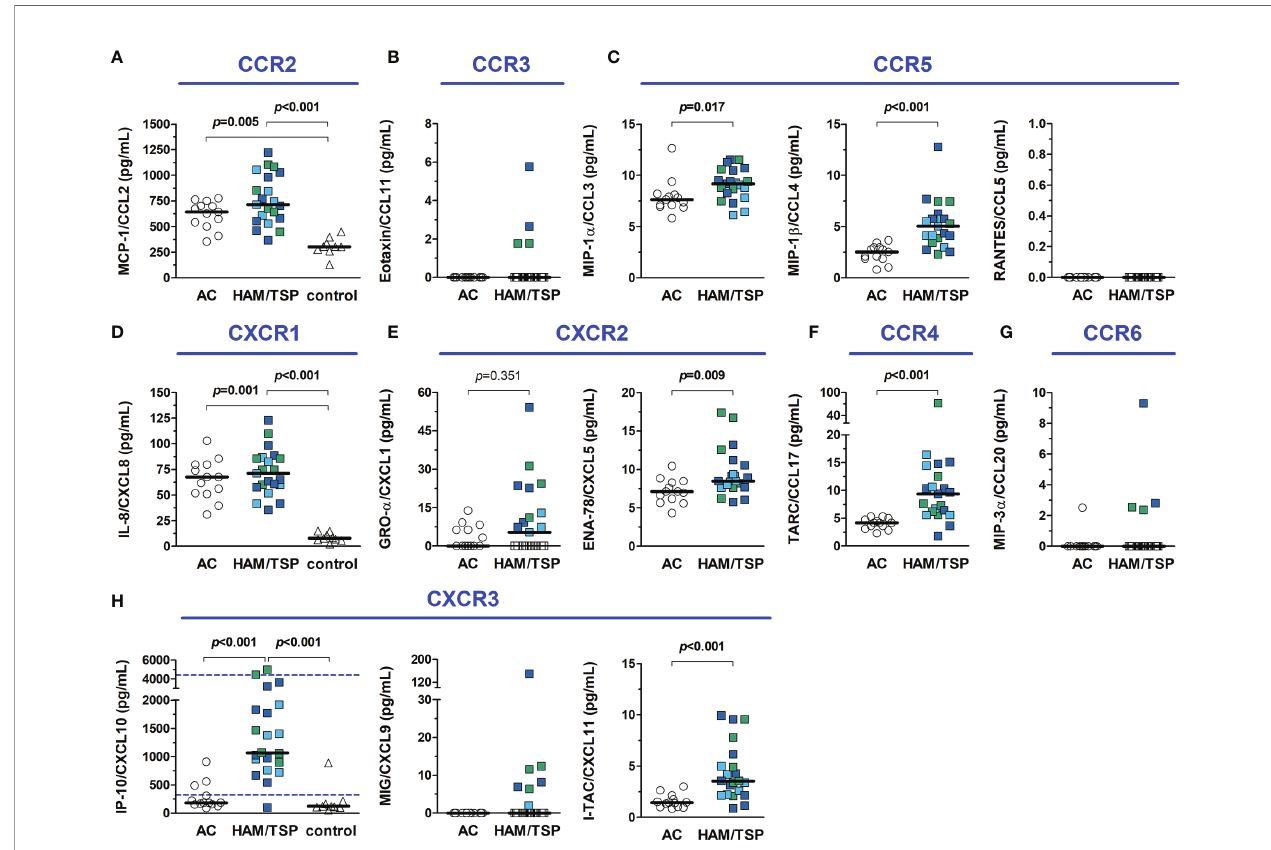
FIGURE 6 | In fl ammatory chemokines in the cerebrospinal fl uid (CSF) of HTLV-1 asymptomatic carriers (AC) and HAM/TSP patients. Chemokines were quanti fi ed with a multiplex cytometry bead-based immunoassay, and graphs were organized according to their respective receptors, shown in blue. (A) CCL2 (B) , CCL11, (C) CCL3, CCL4 and CCL5, (D) CXCL8, (E) CXCL1 and CXCL5, (F) CCL17, (G) CCL20, and (H) CXCL9, CXCL10 and CXCL11. HAM/TSP patients were identi fi ed according to the speed of disease progression as very slow (light blue), typical/slow (dark blue) and rapid (green). Comparisons between two groups were performed with Mann-Whitney test, and the analysis between three groups was carried out with Kruskal-Wallis test with Dunn ’ s post-test for multiple comparisons, and differences with p-value < 0.05 were considered signi fi cant. Dashed lines in the graph for IP-10/CXCL10 data represent the upper and lower cut-offs for CXCL10 concentration in the CSF to predict the speed of HAM/TSP progression as very slow (< 320 pg/mL), typical/slow (320 – 4,399 pg/mL), and rapid ( ≥ 4,400 pg/mL), as proposed by Sato et al.